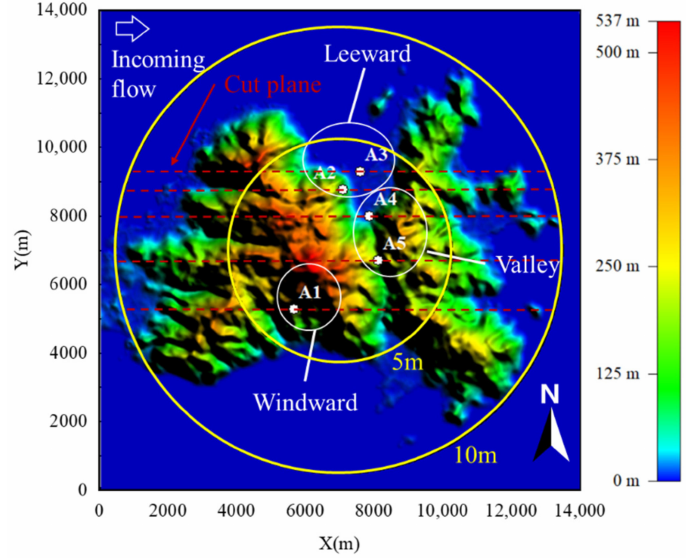
Figure 1. Topography of island and measurement